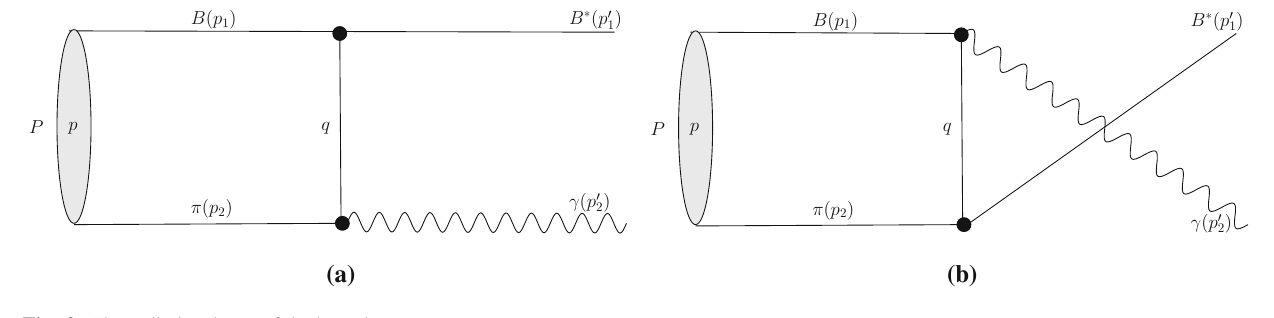
Fig. 2 The radiative decay of the bound state